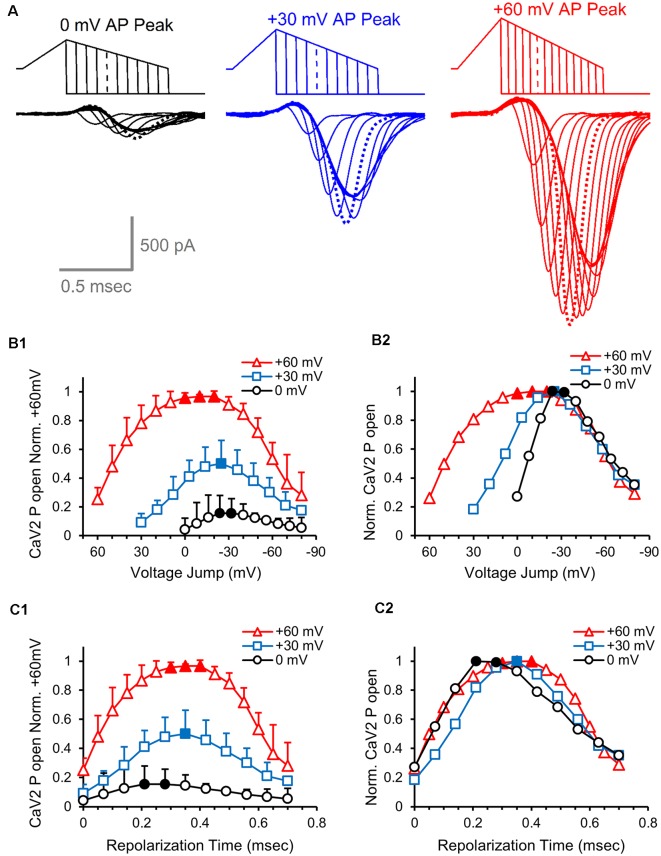
Effects of action potential amplitude on the number of active calcium channels at different times during the action potential. (A) Overlay of presynaptic CaV2 responses to hyperpolarizing voltage-jumps used to determine the relative number of open CaV2 channels at different points during the repolarization phase of an AP-like stimulus with peak amplitudes of 0 mV (black), 30 mV (blue) or 60 mV (red). Peak activation levels are indicated by dashed lines. (B1) Cav2 open probability measured by the peak amplitudes of the CaV2 responses to hyperpolarizing voltage-jumps. The values from each cell were normalized to the responses from the +60 mV stimulus, and the normalized data from each cell were averaged. The graph shows the relative differences in the number of active CaV2 channels at different repolarization membrane potentials for AP-like stimuli that peak at 0, 30 or 60 mV. Panels (B1–C2), n = 5 cells. (B2) Relative CaV2 open probability produced by normalizing the values from panel (B1) to the peak response generated by each stimulus. (C1) Cav2 open probability measured by the peak amplitudes of the CaV2 responses to hyperpolarizing voltage-jumps. The data shown are from panel (B1), with the values adjusted to show the response at specific repolarization times for the AP-like stimuli that peak at 0, 30 or 60 mV. The values from each cell were normalized to the responses from the +60 mV stimulus, and the normalized data from each cell were averaged. (C2) Relative CaV2 open probability produced by normalizing the values from panel (C1) to the peak response generated by each stimulus.